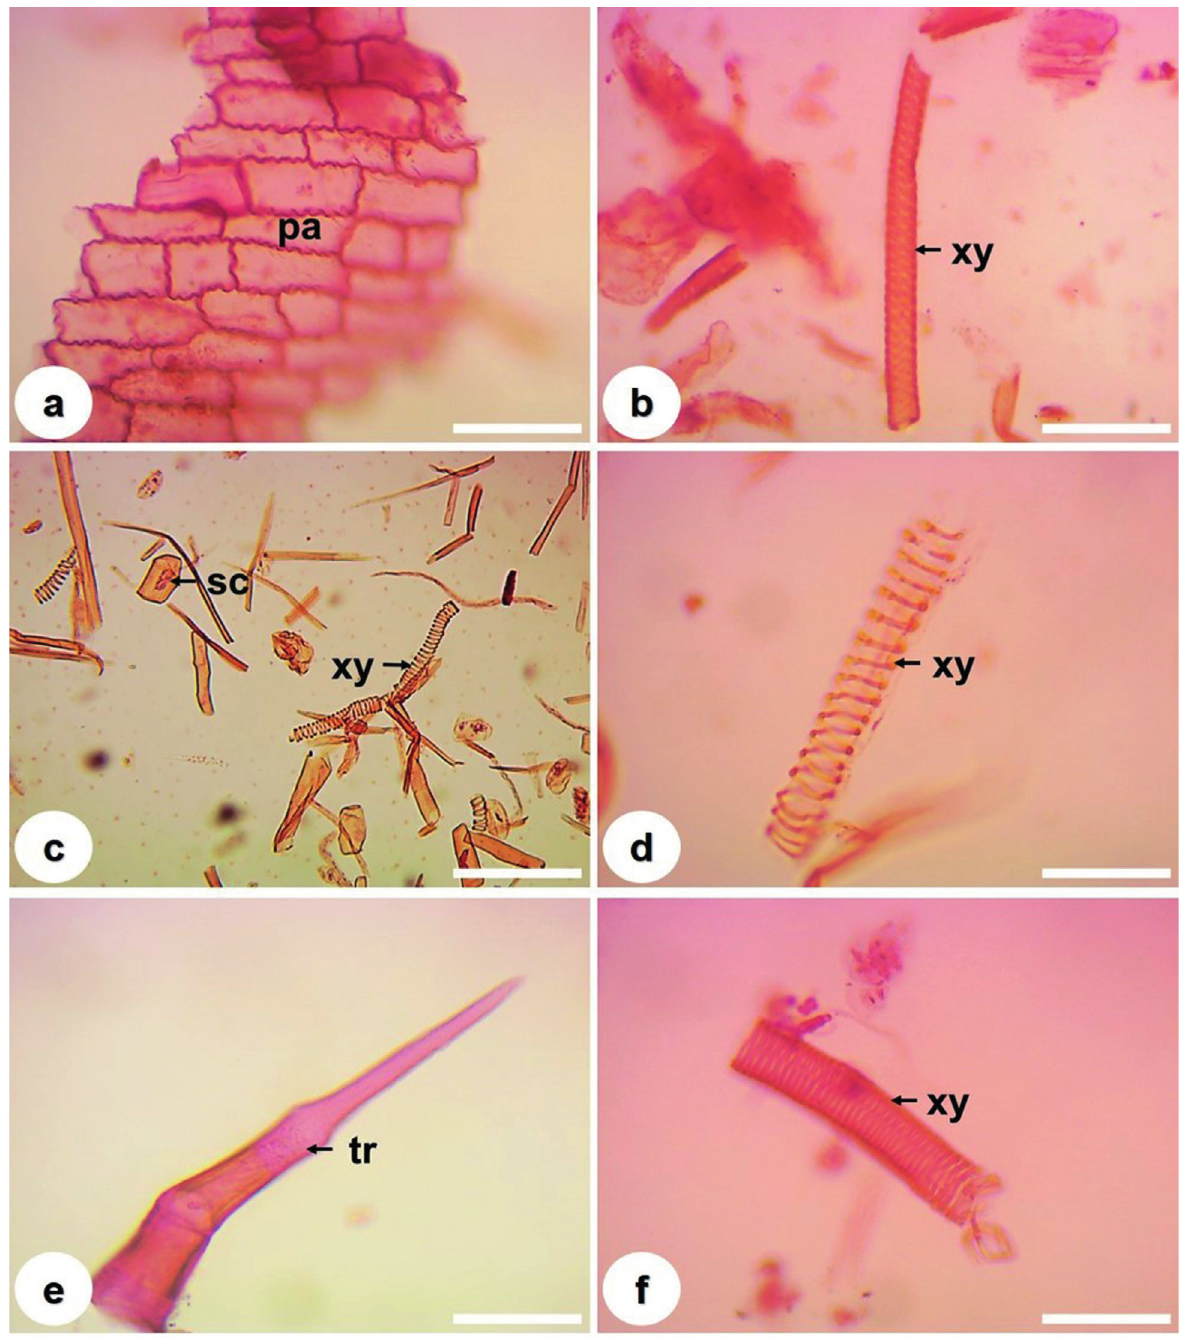
Figure 4 - Solidago chilensis Meyen (Asteraceae), maceration of root, stem and leaf. (a) Maceration of the root, showing parenchymatic cells (pa). (b) Maceration of the root, showing detail of vessel element of xylem (xy) of the helical type. (c) Maceration of the stem, showing stone cells (sc) and vessel elements of xylem (xy). (d) Maceration of the stem, showing detail of vessel element of xylem (xy) of the helical type. (e) Maceration of the leaf, showing non-glandular trichome (tr). (f) Maceration of the leaf, showing detail of vessel element of xylem (xy) of the helical type. Bars: a , b , d , e and f = 50 µm; c = 200